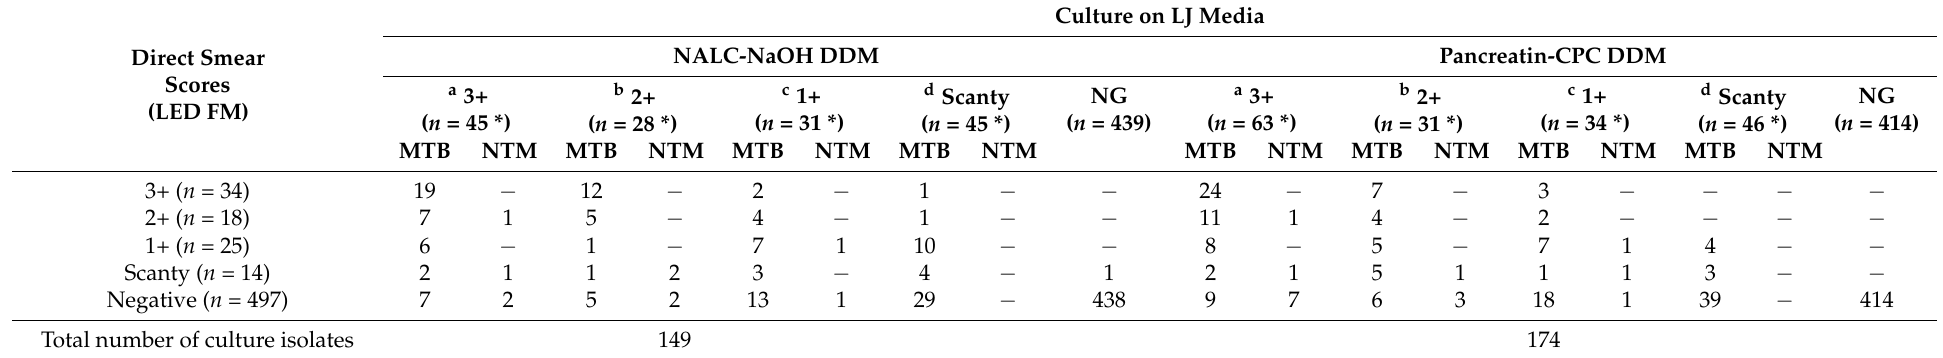
Table 3. Culture results yielded after digestion and decontamination with NALC-NaOH and Pancreatin CPC DDM as shown by LED-FM direct